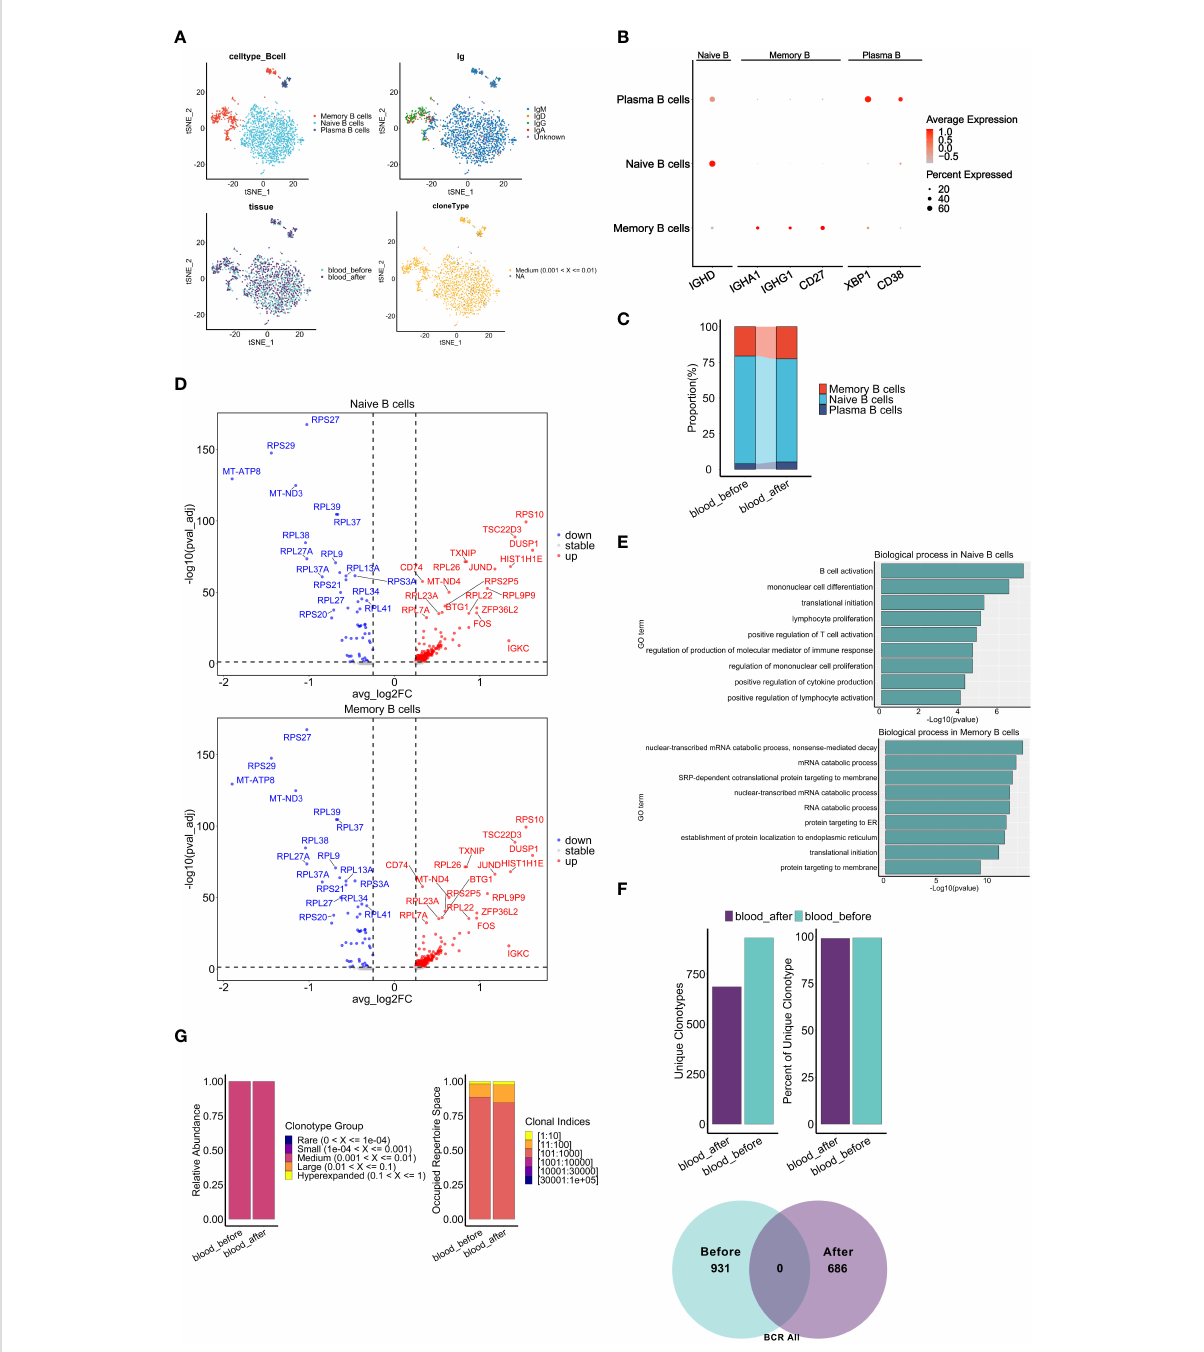
FIGURE 7 Characteristics of B cell subclusters before and after chemotherapy. (A) t-SNE visualization of B cells colored by cell types (top left), BCR isotypes (top right), derived-samples (bottom left) and clonal expansion status(bottom right). (B) Dot plots show expression level of marker genes of B cell types. (C) Proportion of B cell subclusters (y axis) in two blood samples(x axis). (D) Volcano plots show DEGs of naive B cells (top panel) and memory B cells (bottom panel) after chemotherapy compared with those before chemotherapy. (E) Gene set enrichment analysis of naive B cells (top panel) and memory B cells (bottom panel) after chemotherapy. The analyses were based on the Msigdbr GO database. (F) Bar graphs top panel and venn diagram bottom panel show the change of frequency and fraction of unique clonotypes, colored by collection time. (G) Clonal homeostatic space representations (clonal space occupied by clonotypes of speci fi c proportions) (left panel) and the relative proportional space occupied by speci fi c clonotypes (right panel) of BCR across samples pre and post chemotherapy. The results above are generated by comparison between samples ( blood_before, blood_after